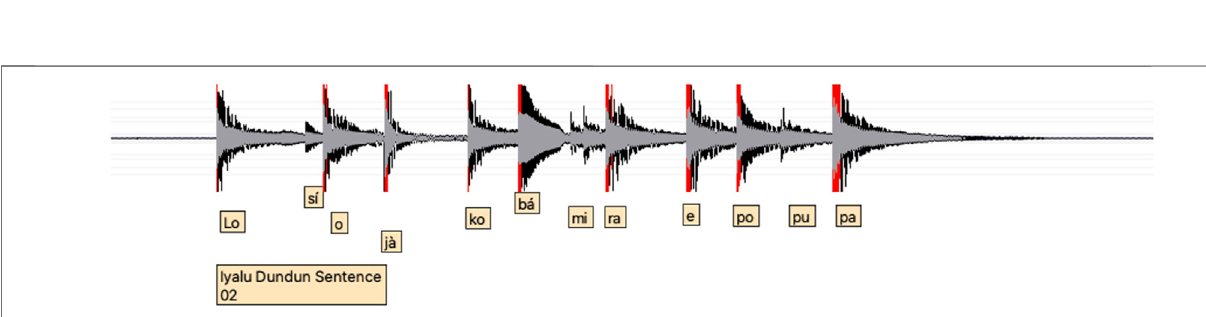
FIGURE 3 | Ìyáàlù dùndún amplitude wave for the sentence “ J ’ òwó sún mó mi. Ìlú we lo ti wá ” ( “ Please come here. Where are you from? ” ).